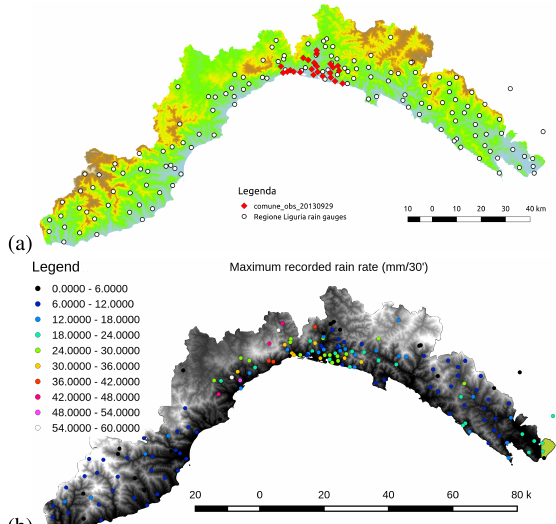
Figure 1: (a) Input rainfall measures at 143 stations (regional level, white points) and 25 stations (municipality level, red cir- cles). (b) Map of the rain rate maximum recorded at each weather station, which highlights that only the central west of the region has been involved by heavy rain and the remaining part were in- terested by